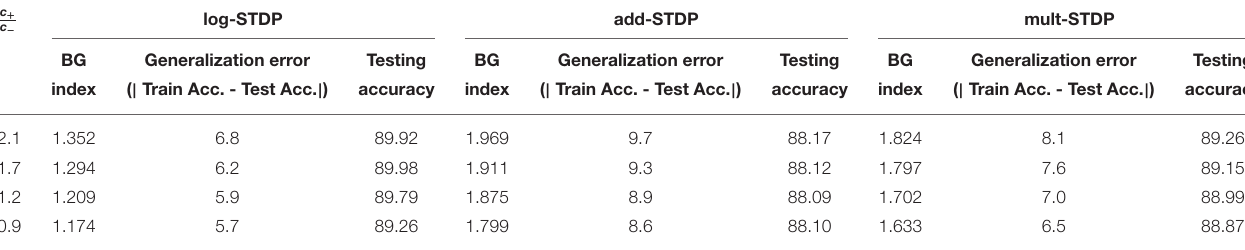
TABLE 2 | Impact of the post-synaptic to pre-synaptic scaling functions ratio on generalization. c + c −